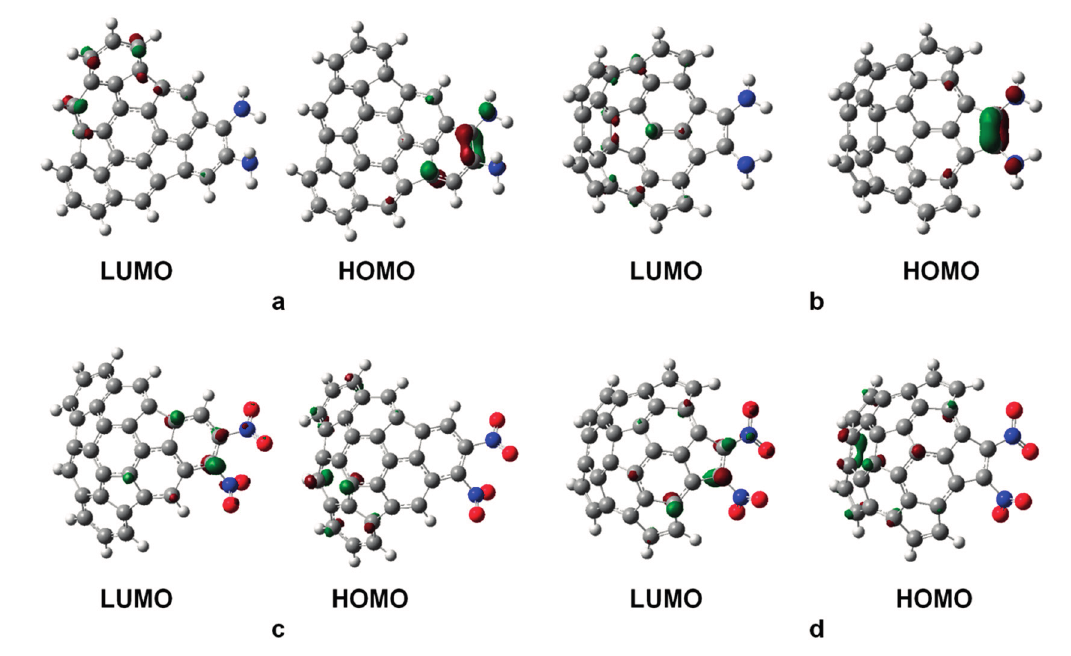
Figure 3. Frontier molecular orbitals HOMO and LUMO of fragments 1 and 2 substituted with two NH 2 molecules (panels a and b ), or two NO 2 molecules (panels c and d ). The substituent molecules are on the right side of the fragments. The large grey, blue and red spheres represent carbon, nitrogen and oxygen atoms, respectively, and hydrogen atoms are represented by the small grey spheres. The dark red and green surfaces represent the positive and negative lobes of the calculated molecular orbitals respectively, plotted at 0.08